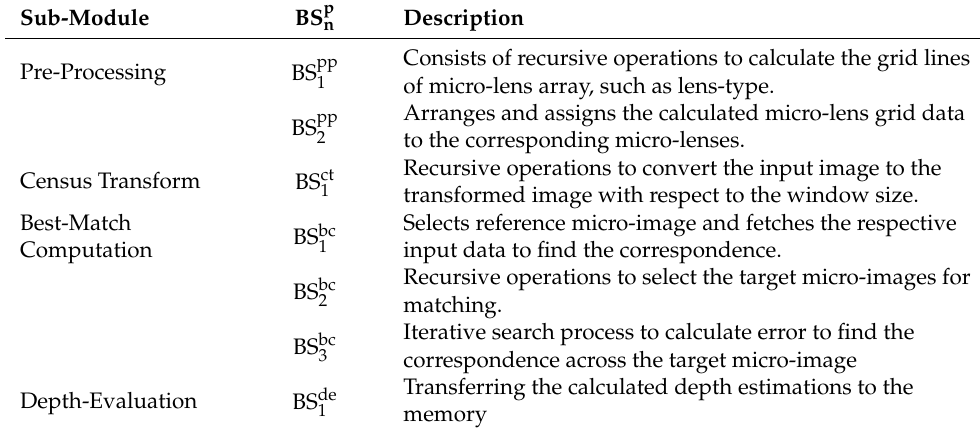
Table 1. Selected BS p n from sub-modules of the